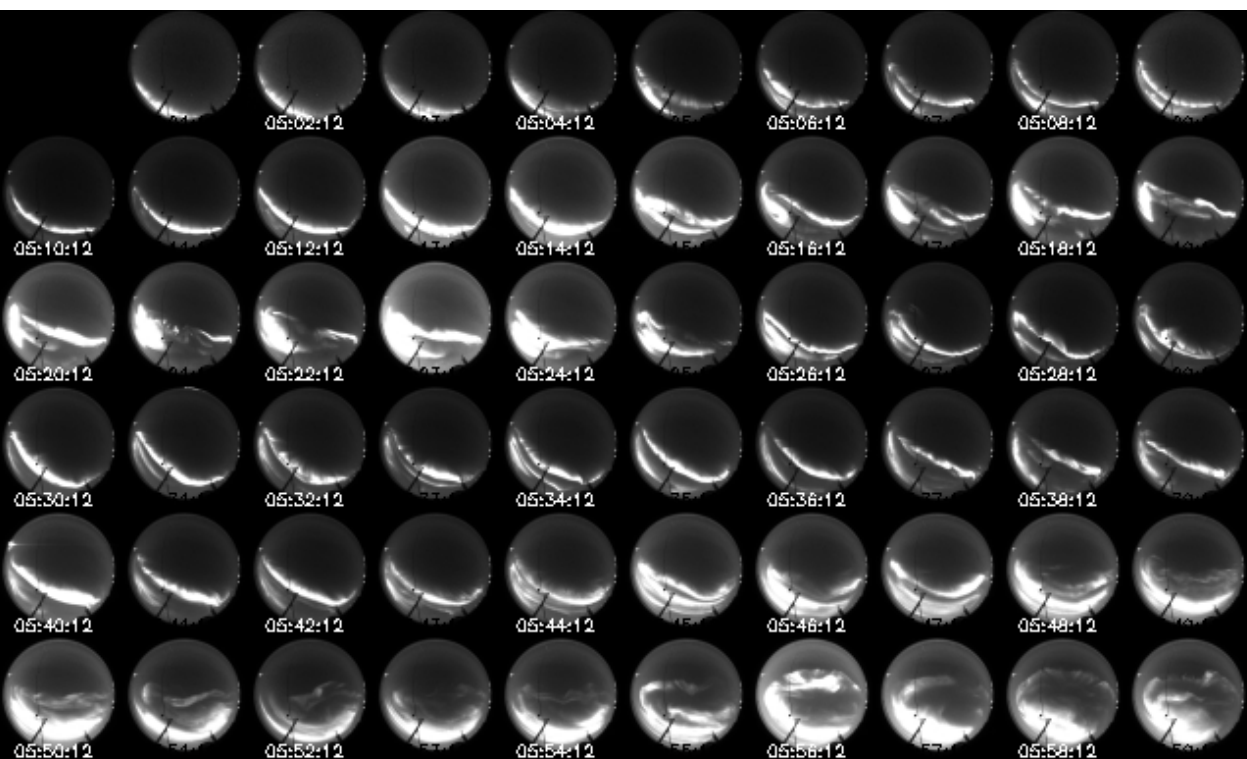
Fig. 3. Series of 557.7-nm emission all-sky images from Taloyoak between 05:00 and 06:00UT on 8 January 2008.